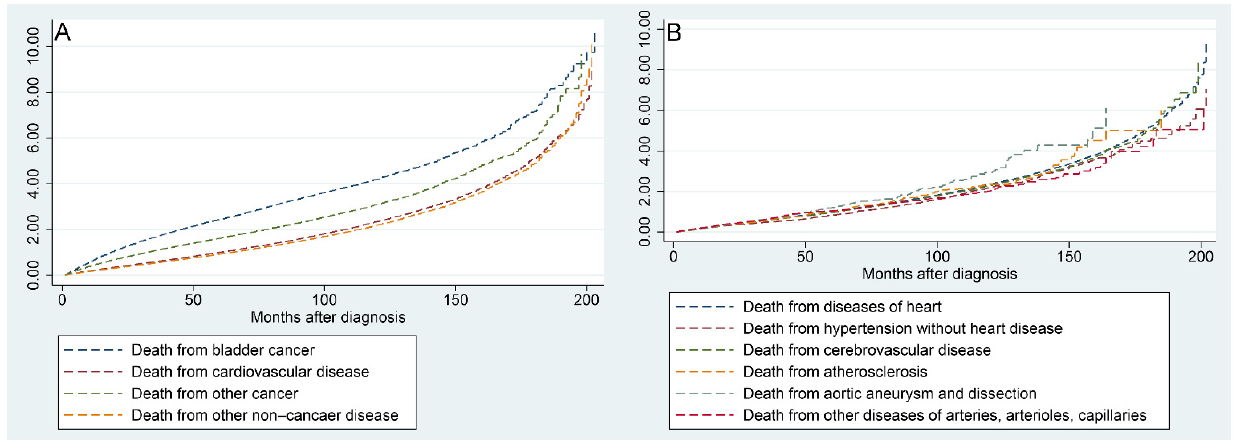
Figure 6. Nelson–Aalen cumulative hazard curves for all causes of death in primary bladder cancer patients ( A ) and stratified by the six factors of cardiovascular disease ( B ).